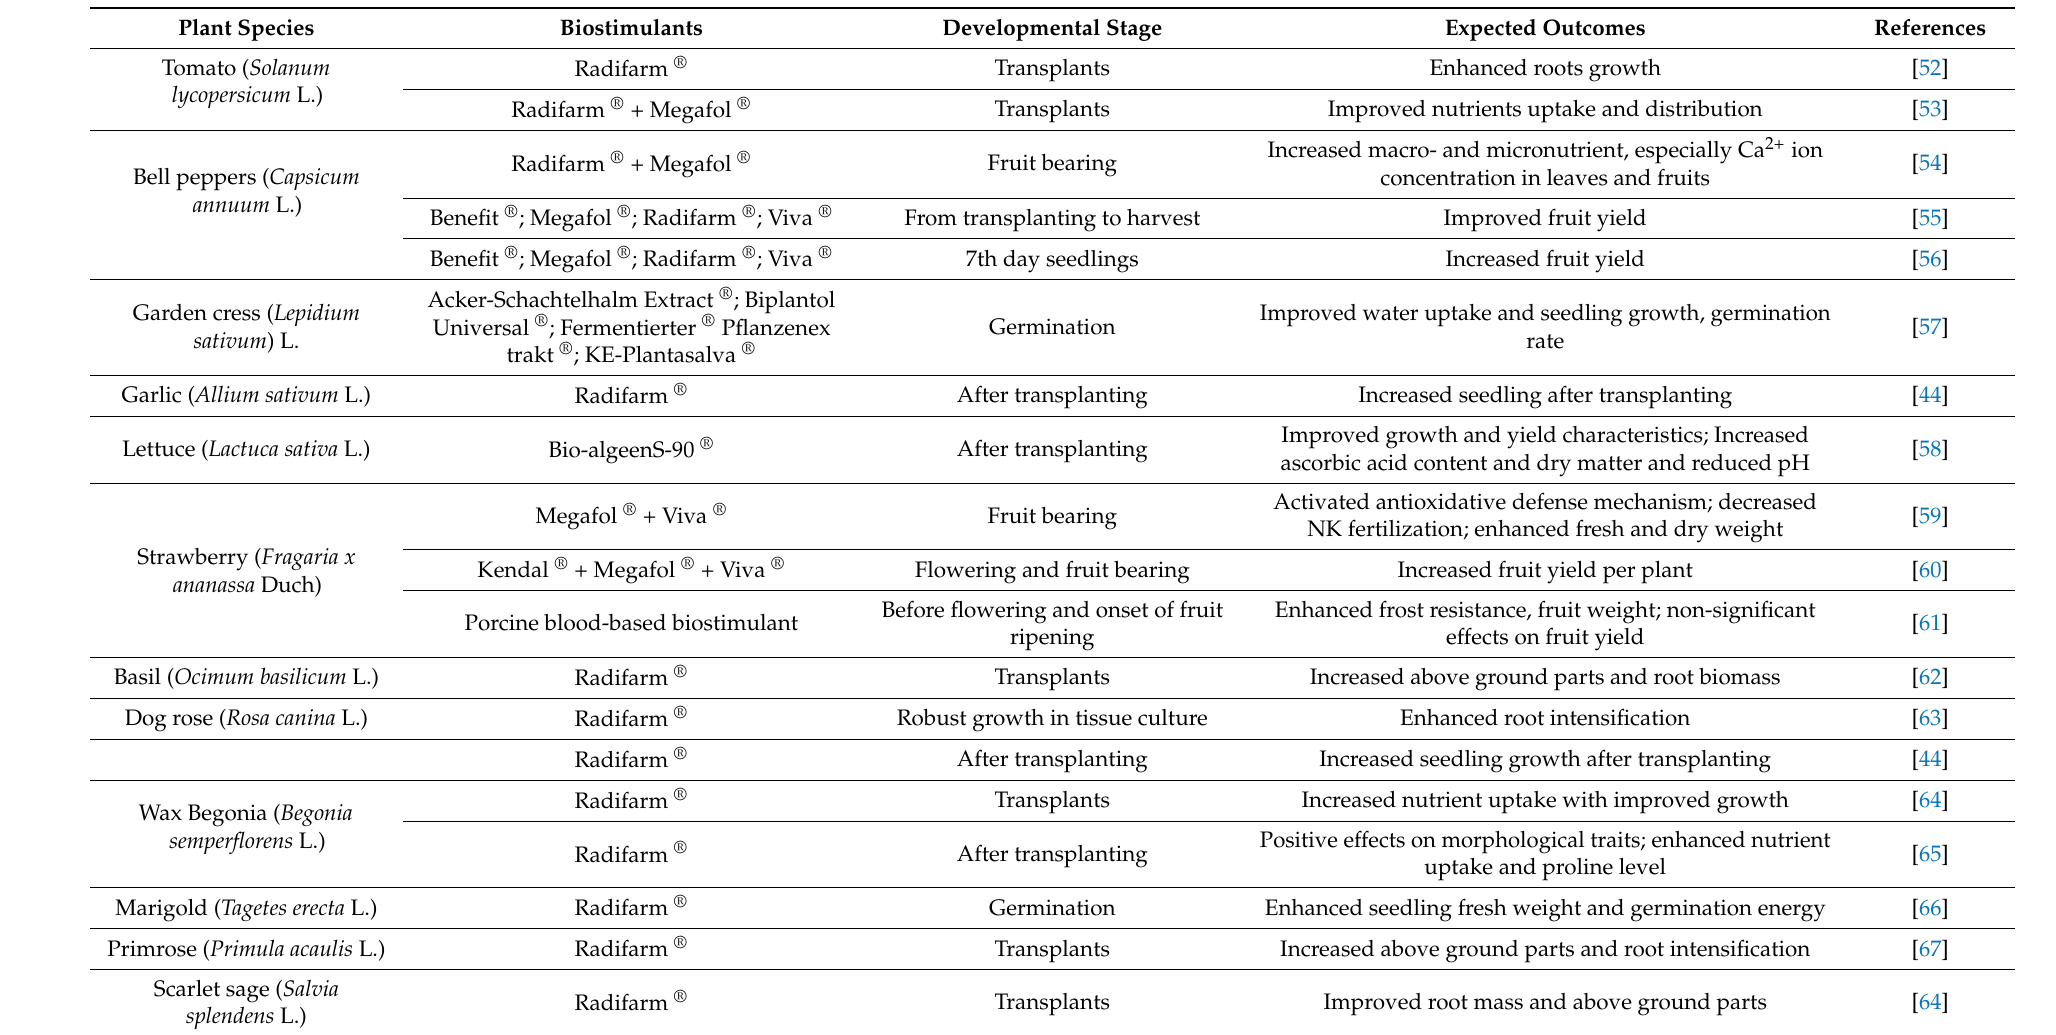
Table 2. Effect of biostimulants on the crop